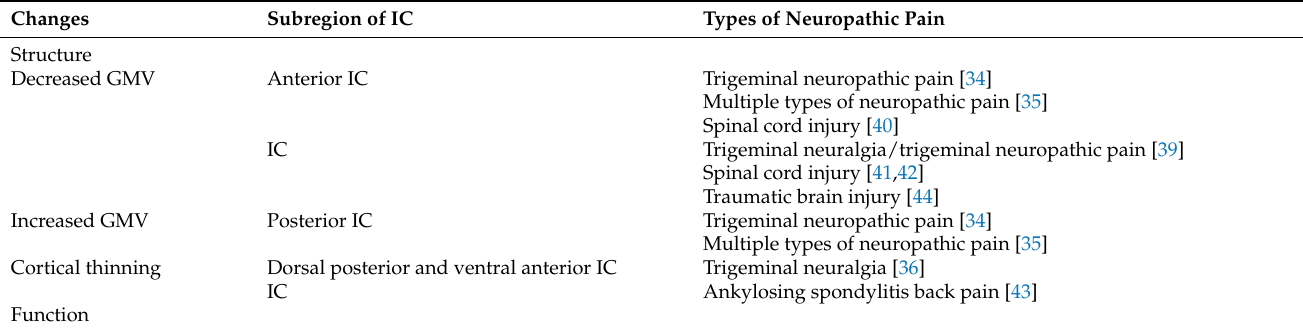
Table 1. Typical structural and functional changes of the insular cortex in neuropathic pain. Changes Subregion of